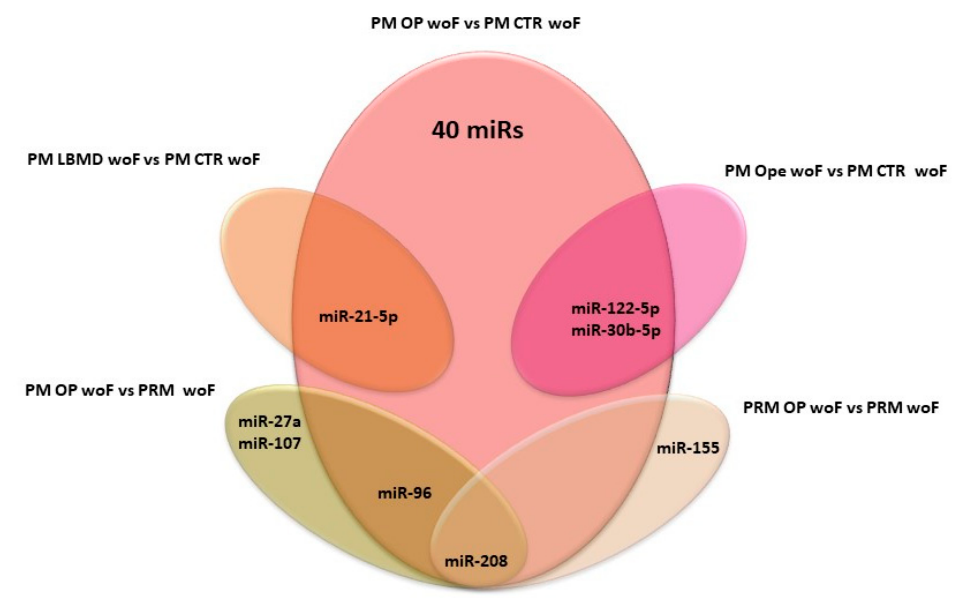
Figure 1. Venn diagram summarizes all the miRs identified as possible biomarkers for LBMD. PM: post-menopause; OP: osteoporosis; PRM: pre-menopause; LBMD: low bone mass density; CTR: control; woF: without fracture.